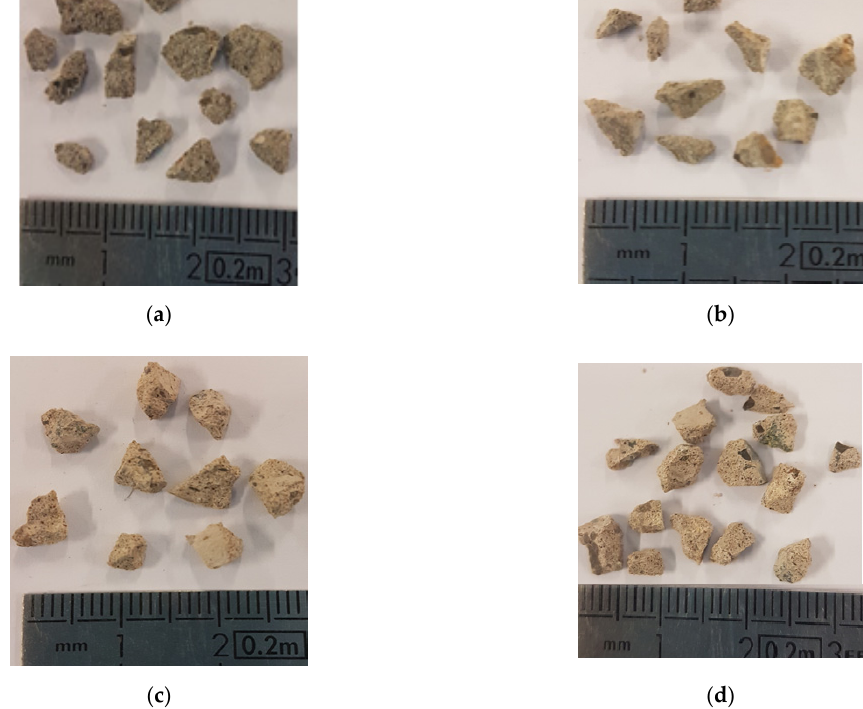
Figure 2. Samples of new pastes before MIP tests ( a ) NP0, ( b ) NP30, ( c ) NP50 and ( d )